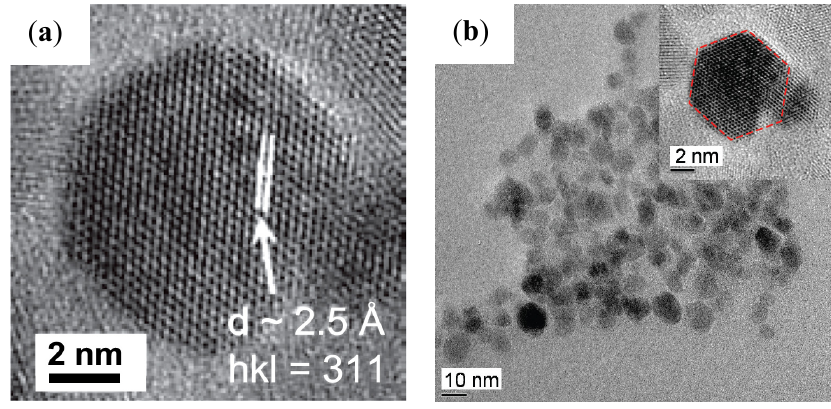
Figure 1. Transmission electron microscopy (TEM) images clearly showing: ( a ) lattice fringes; and ( b ) facetted shapes for nanoparticles (NPs) coated with oleic acid, using ) at room temperature. Reprinted with permission 10 equivalents of reducing agent (NaBH 4 from [4]. Copyright 2011 WILEY-VCH Verlag GmbH and Co. KGaA,